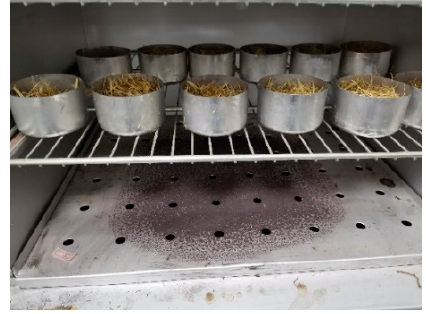
Figure 8. Straw drying after crushing experiment.